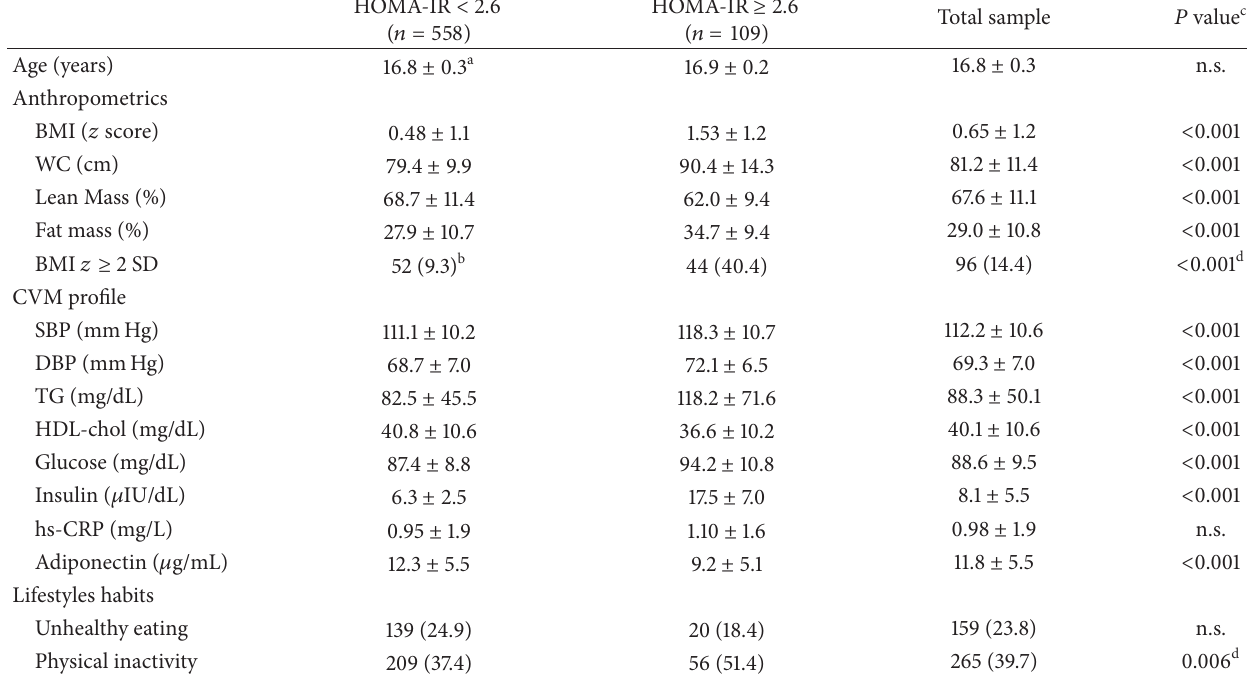
Table 1: Background characteristics of adolescents in the sample by insulin sensitivity ( 𝑛 = 667 ).